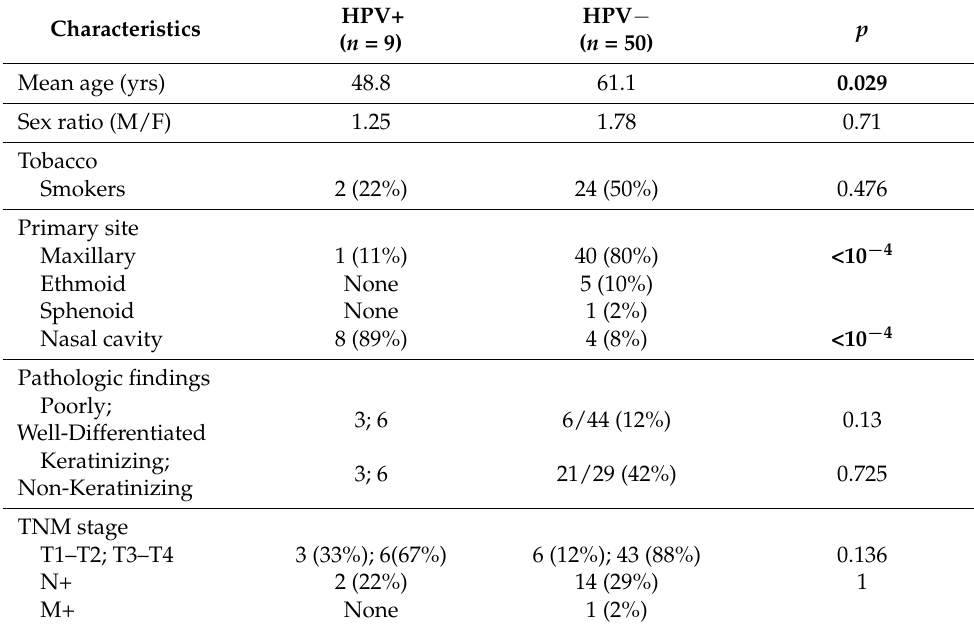
Figure 4. P16 expression on immunohistochemistry: positive ( left ); negative ( middle ); doubtful ( right ). Table 2. Patient and tumor characteristics according to HPV status. Table 2. Patient and tumor characteristics according to HPV status.